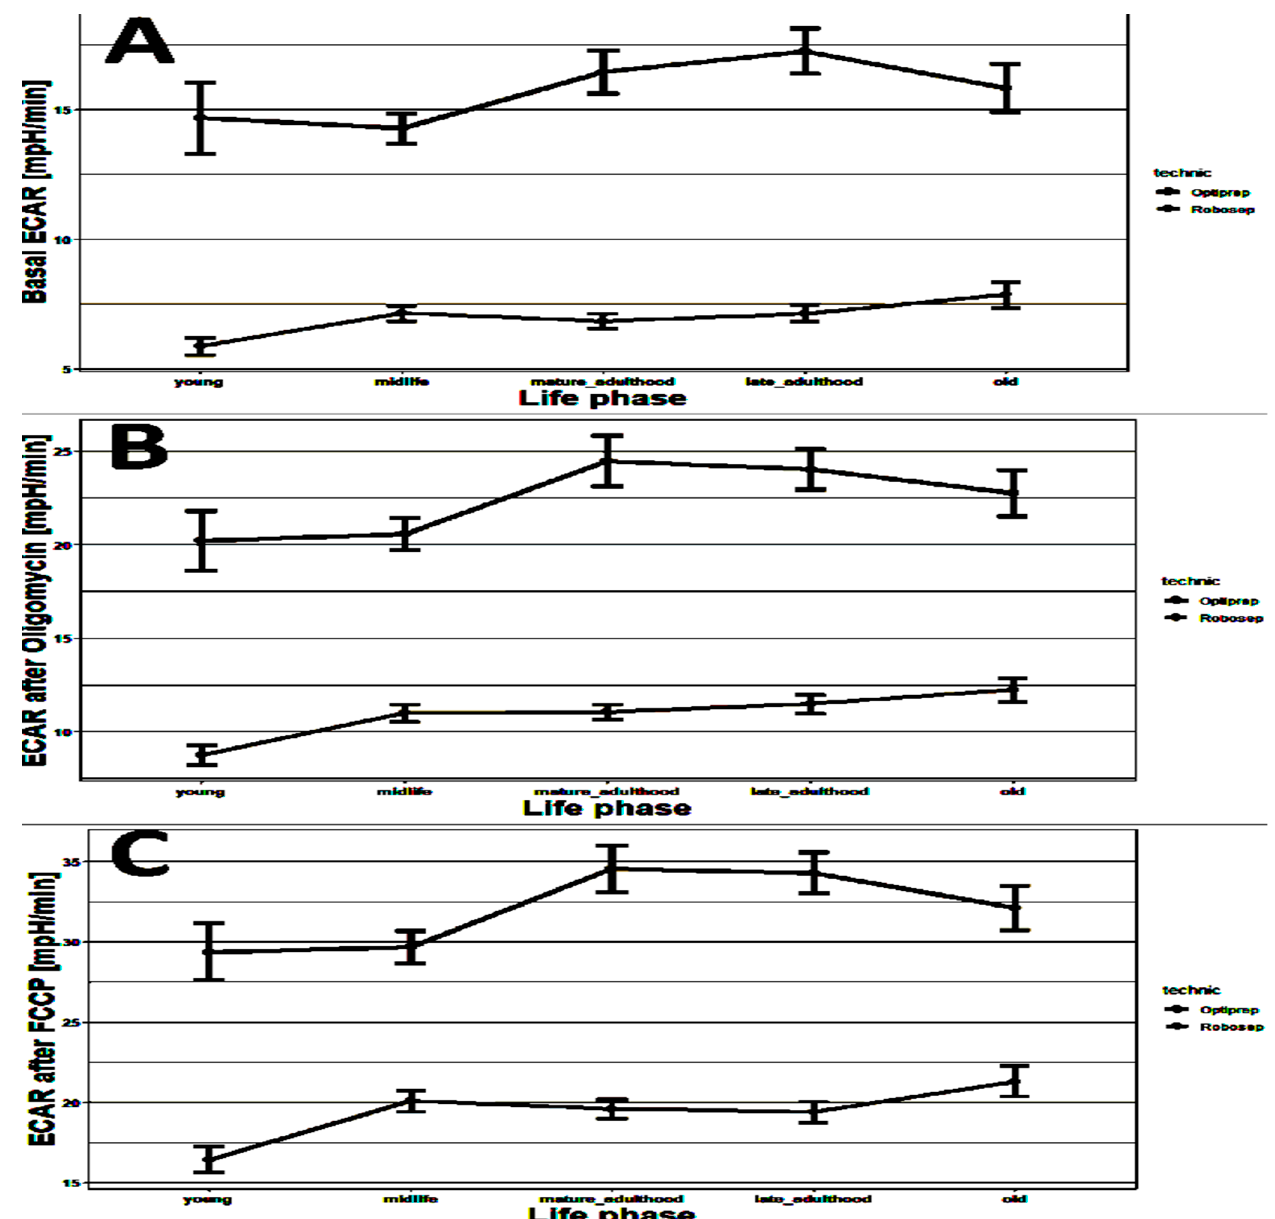
Figure 5. Changes in basal ECAR (mpH/min) ( A ), ECAR oligomycin (mpH/min) ( B ) and maximal ECAR (FCCP) (mpH/min) ( C ) with age observed in Opti-isolated PBMCs (black, n = 302) and Robo-isolated PBMCs (gray, n = 216). Young = 12 to 35 years; midlife = 35 to 50 years; mature adulthood = 50 to 60 years; late adulthood = 60 to 70 years; and old = 70 to 90 years. The horizontal lines show the mean ± SD.